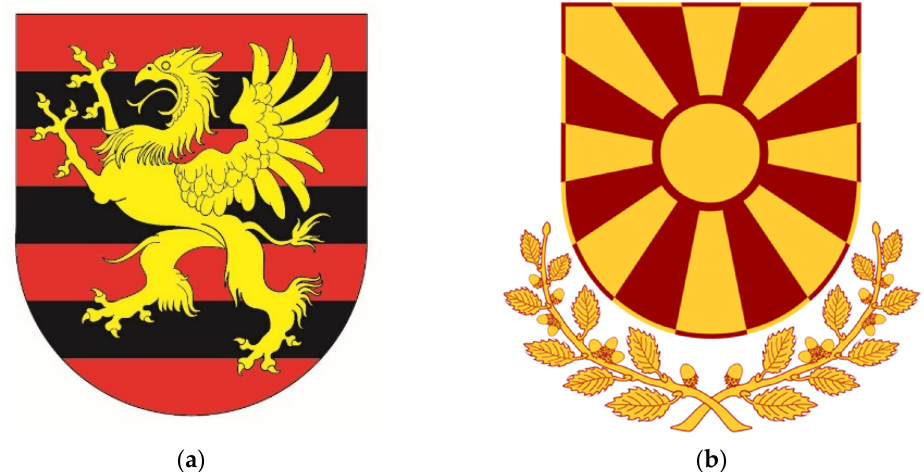
Figure 24. ( a ) Proposal for the arms of the President of the Republic of Macedonia; ( b ) Official arms of the President of the Republic of Macedonia.